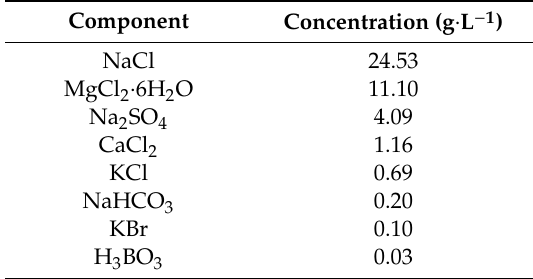
Table 2. Composition of artificial seawater, according to Mobin et al.